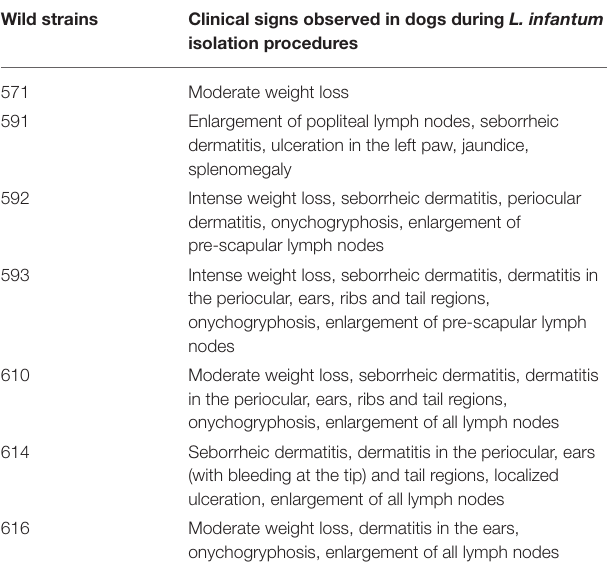
TABLE 1 | Clinical features of canine visceral leishmaniasis after isolation of L. infantum strains from naturally L. infantum -infected dogs. Wild